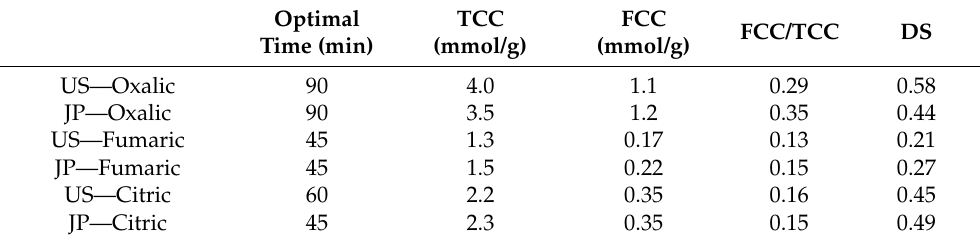
Table 1. Optimized times, total carboxyl groups content (TCC), free carboxyl groups (FCC), and